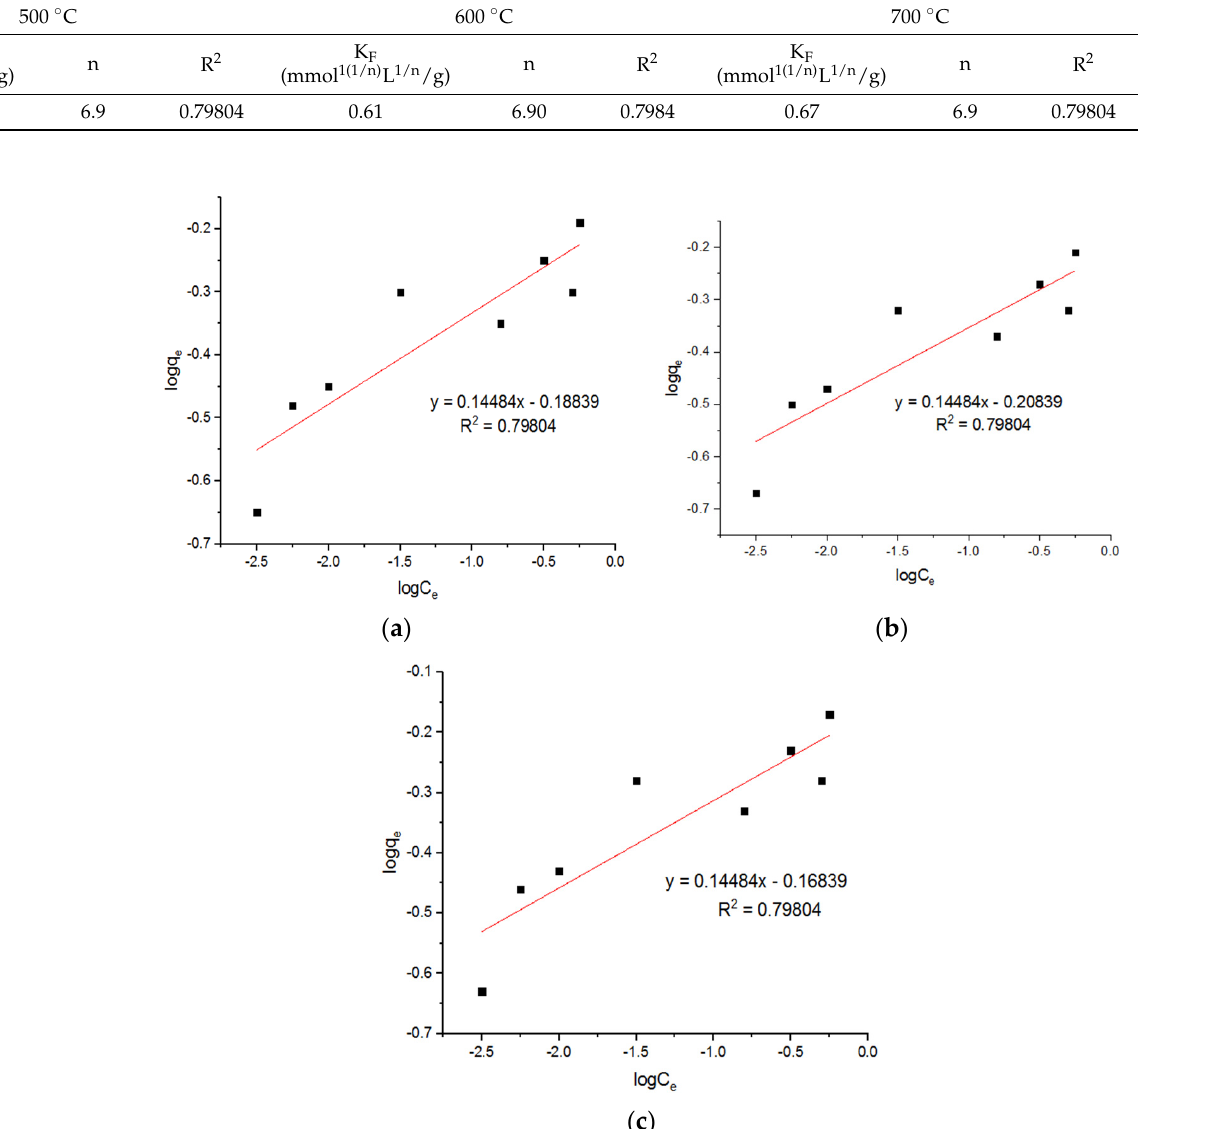
Figure 16. Freundlich plots for adsorption of Pb 2+ onto MgFe 2 O 4 -NH 2 nanoparticles pre-functionalization-calcined at ( a ) 500 °C, ( b ) 600 °C, and ( c ) 700 °C.